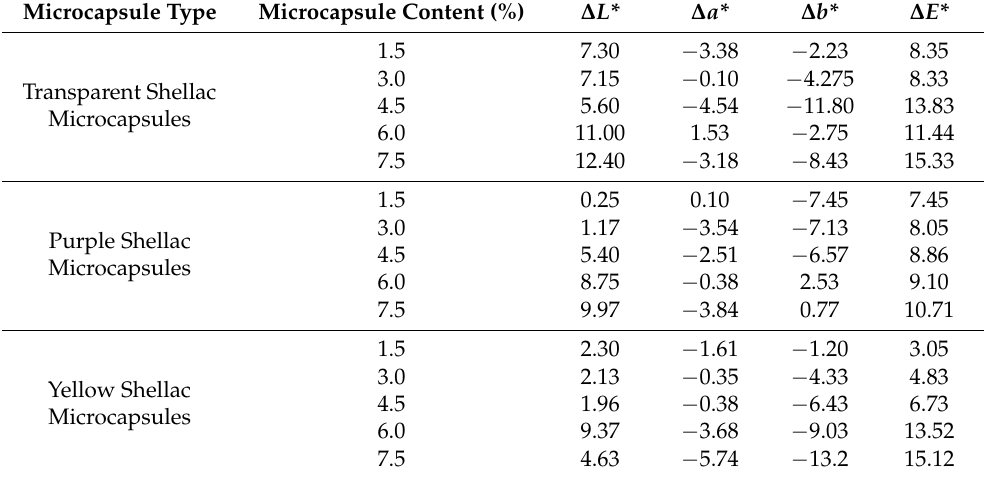
Table 2. The ∆ E* of coatings with the different content of different shellac microcapsules based on the Beli wood